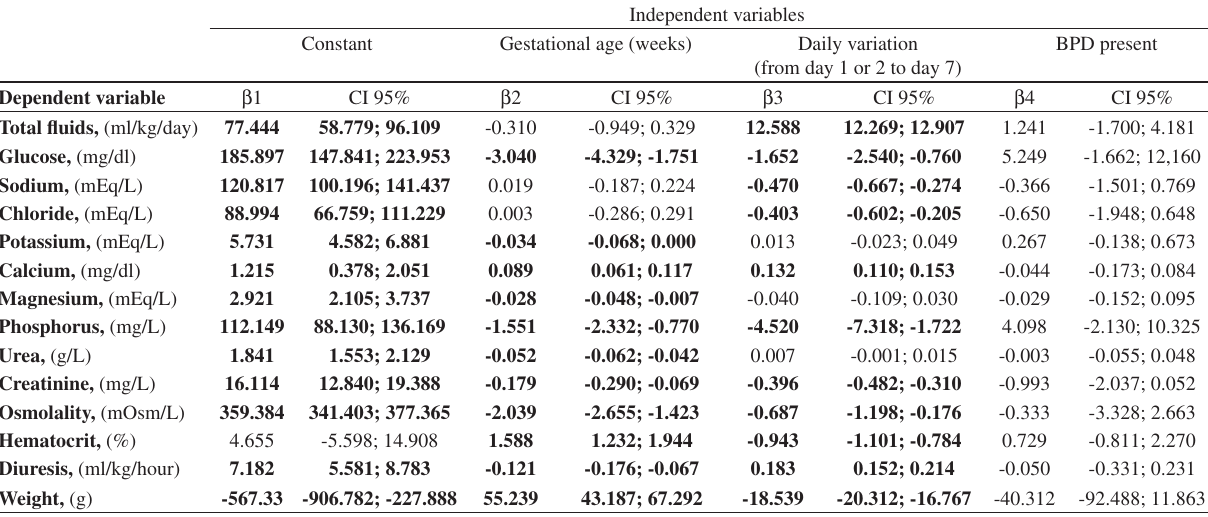
Table 5 - Multivariate model of the generalized estimation equation (GEE) of the longitudinal variation (from the first or second day of life to the seventh) of total fluids, glucose, electrolytes, urea, creatinine, osmolality, hematocrit, diuresis and weight adjusted to gestational age, daily variation, BPD and clinical intervention (when indicated).